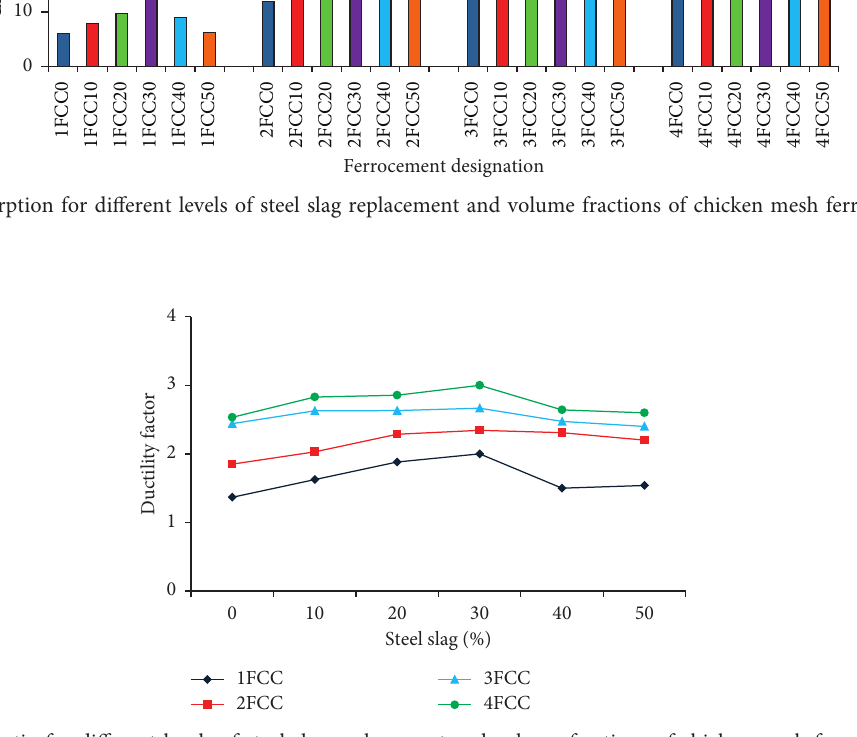
Figure 10: Ductility ratio for different levels of steel slag replacement and volume fractions of chicken mesh ferrocement